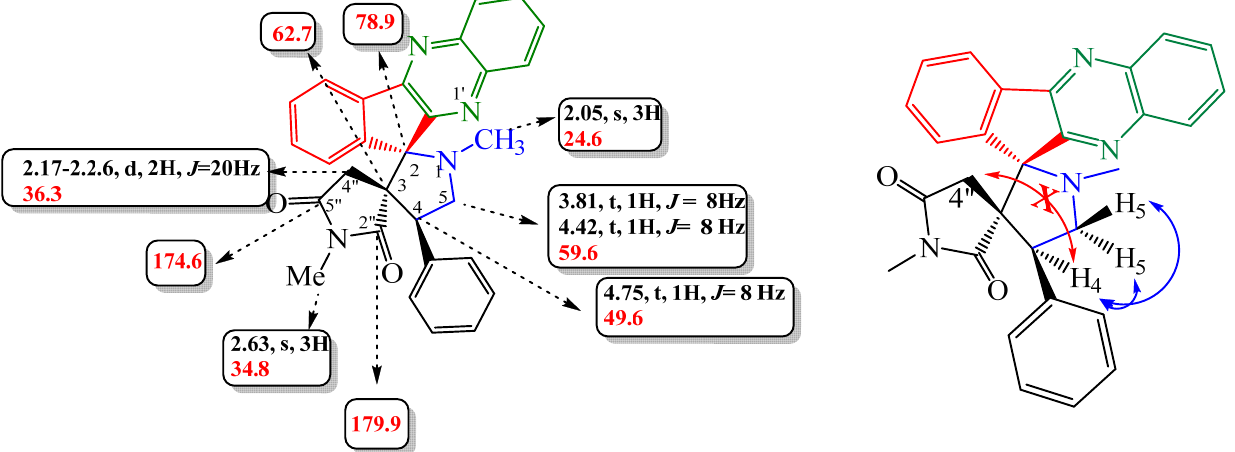
Figure 2. Selected 1 H and 13 C NMR (red) chemical shifts (ppm) (left) and the NOESY correlations (right) of 5a .